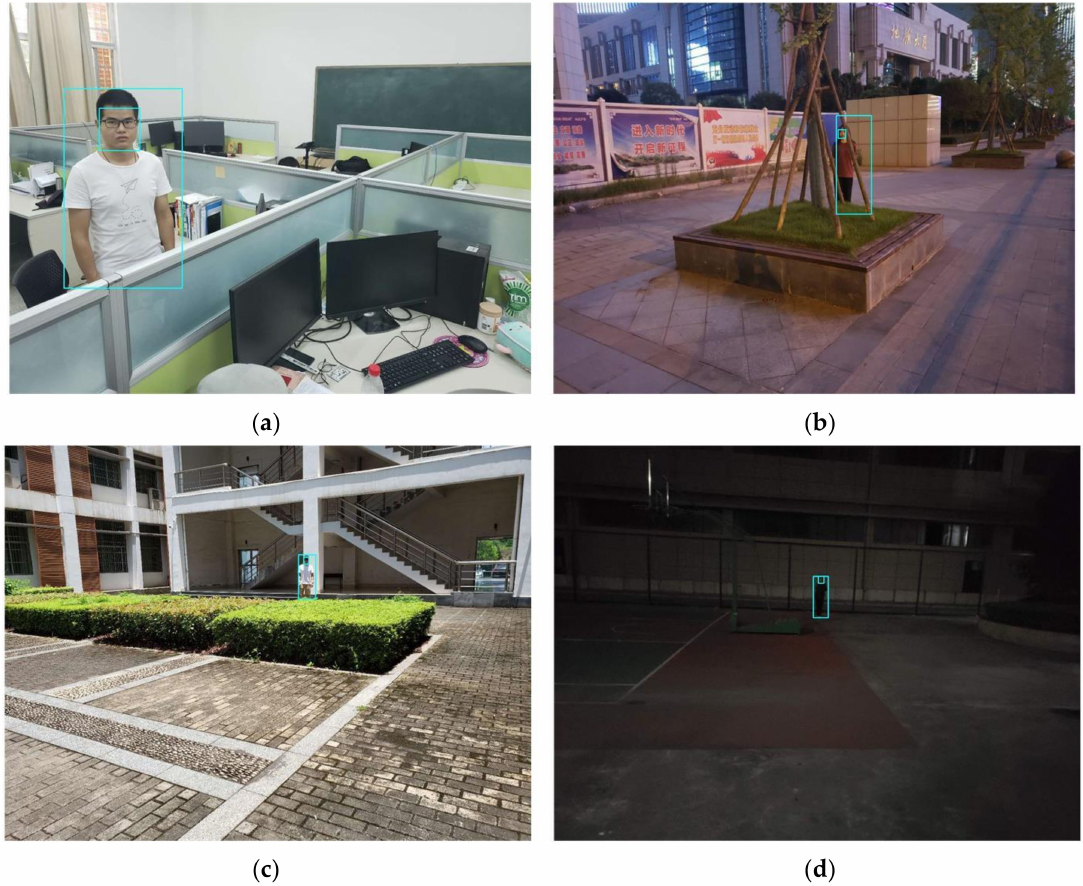
Figure 2. Face detection in di ff erent situations based on pre-identification mechanism and a cascaded detector (PMCD): ( a ) the face detected with occlusion on some part of the body; ( b ) the face detected with occlusion on some part of the body in complex backgrounds; ( c ) the tiny face detected with good light; ( d ) the tiny face detected with poor light.